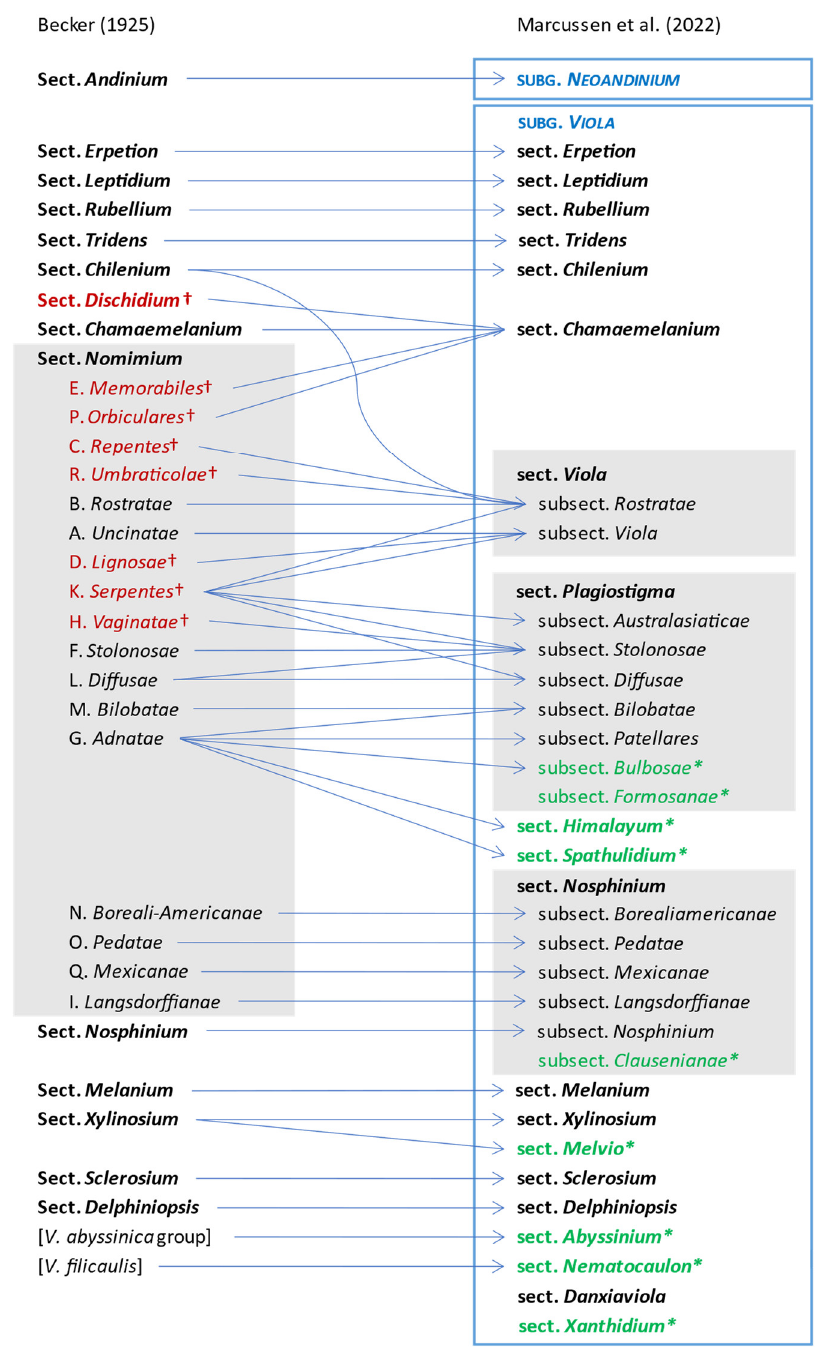
Figure 7. Wire diagram illustrating the major taxonomic differences between the phylogenetic classification of Viola proposed here (“Marcussen et al. 2022”) compared to the morphological classification proposed by Becker (1925 [1]). Merging lines denote lumping of two or more of Becker’s infrageneric groups into one taxon, while splitting lines denote segregation into two or more taxa. Taxa placed on the same line and interlinked with a horizontal line are synonymous, but may differ in delimitation, rank, or name (for reasons of priority). Taxa indicated with a dagger have been reduced to synonymy under another taxon. Taxa indicated with an asterisk are new infrageneric segregates described here. We do not show infrasectional taxa for sect. Chamaemelanium , which are not accepted here, or for sect. Melanium and the sect. Andinium /subg. Neoandinium pair, for which our treatments differ substantially from that by Becker.